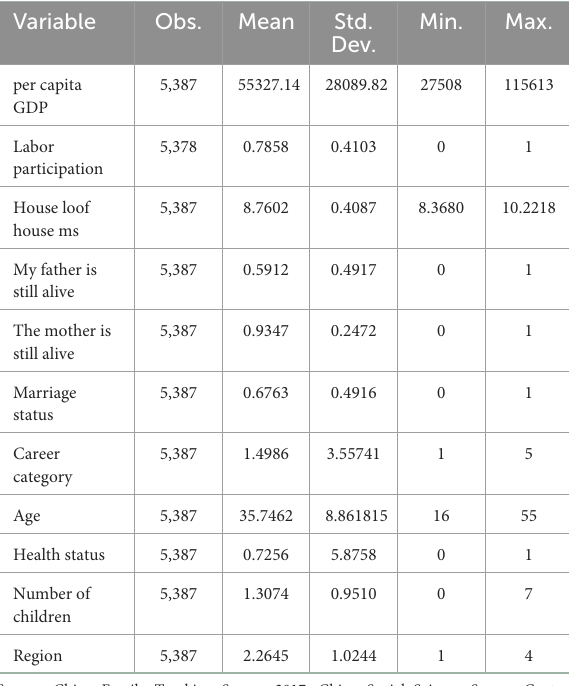
TABLE 1 Descriptive statistics of the variables. Variable Obs.